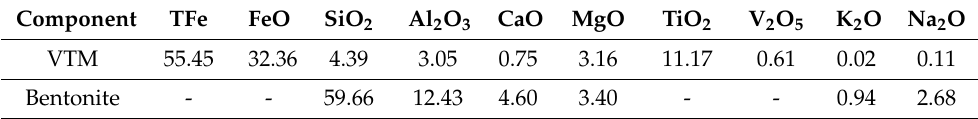
Table 1. Chemical composition of VTM concentrate and bentonite/wt%. Component